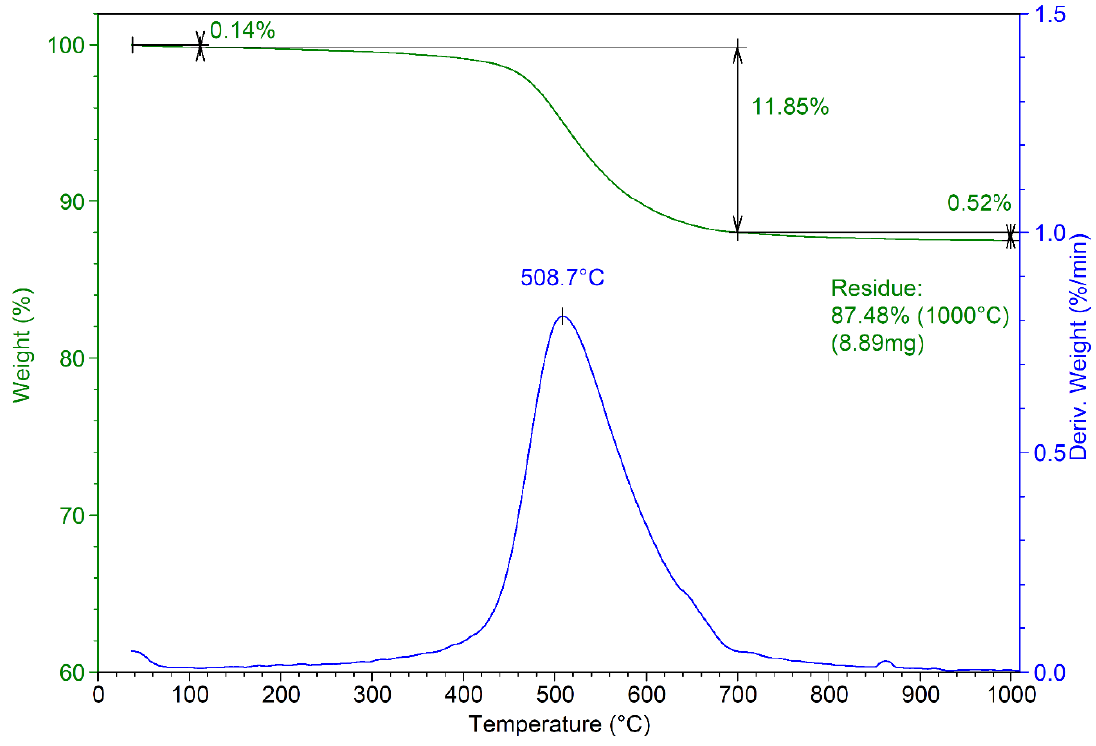
Figure 4. Thermogram of the developed composite material (MnHAP-M).